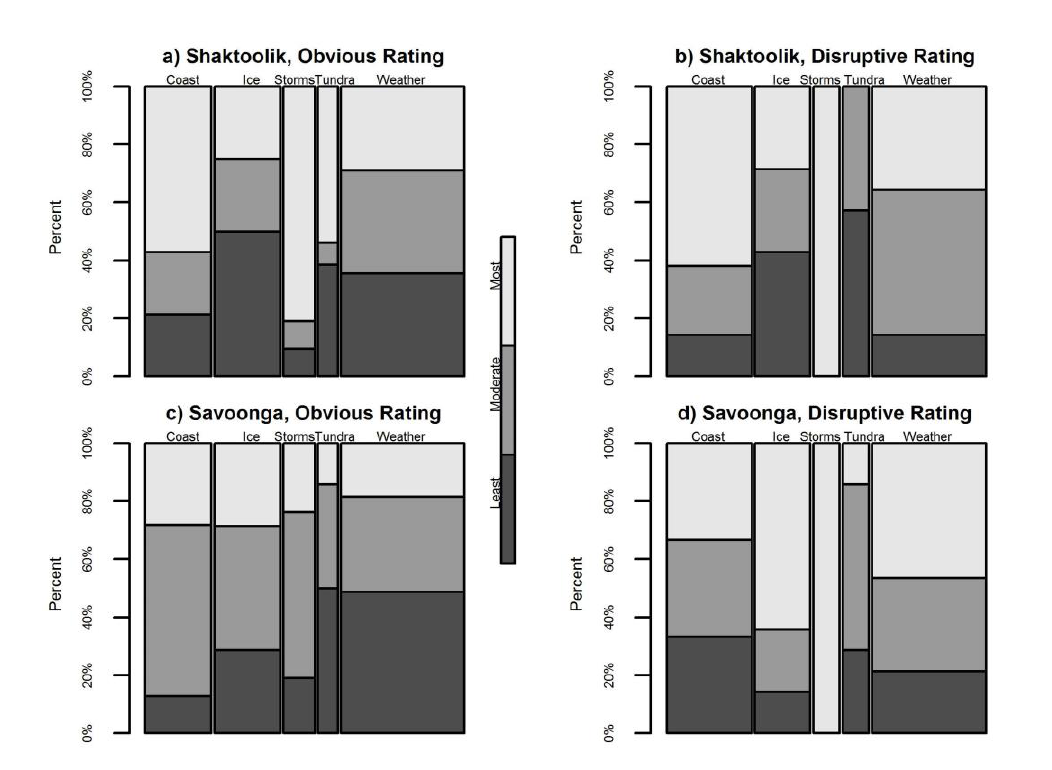
Figure 3. ( a ) Mosaic plots examining the relationship between categories and obviousness ( b ) rating and disruptiveness ( c , d ) rating for Shaktoolik and Savoonga. Widths of the broad categories correspond to the number of specific climate change-related changes in the broader